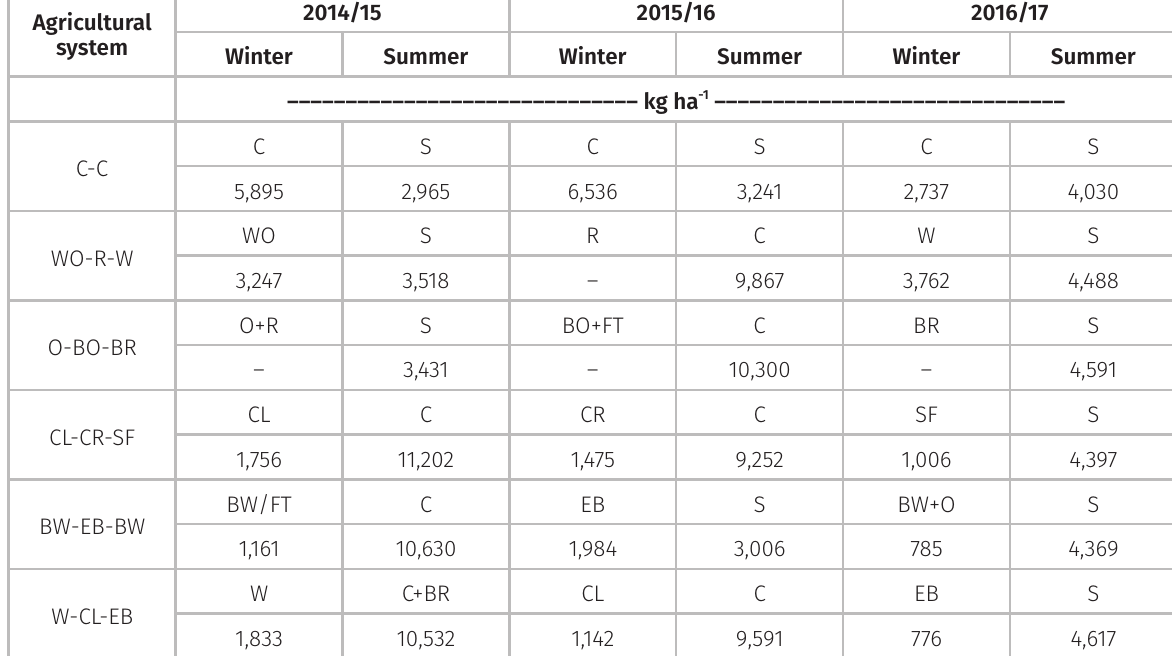
Table II. Production system yields, for the crop years of 2014/15, 2015/16, and 2016/17. Agricultural